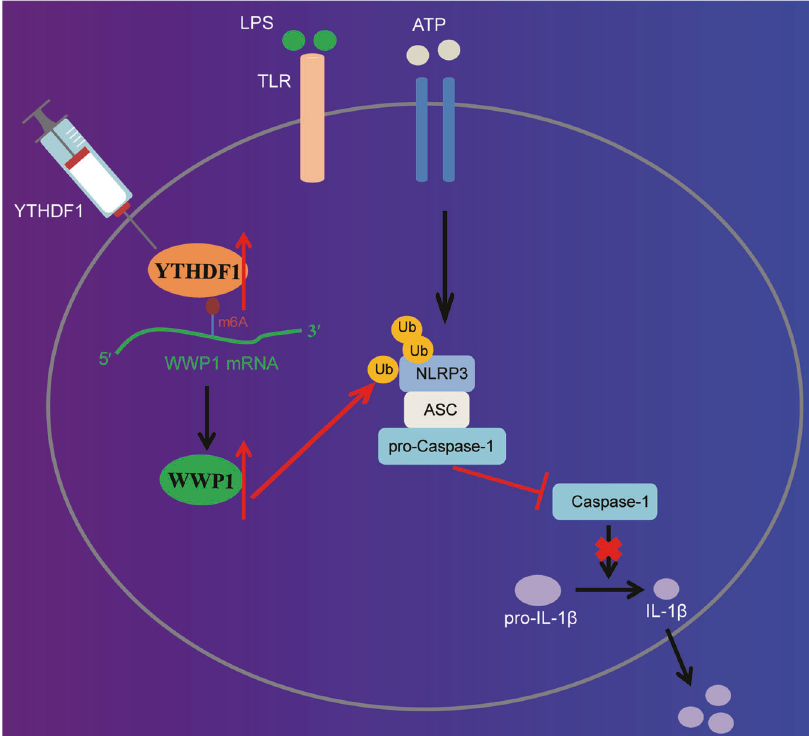
Fig. 6 The molecular mechanism of m6A reader protein YTHDF1 in sepsis. YTHDF1 upregulates WWP1 to promote NLRP3 ubiquitination, which inhibits caspase-1-dependent pyroptosis, thereby alleviating